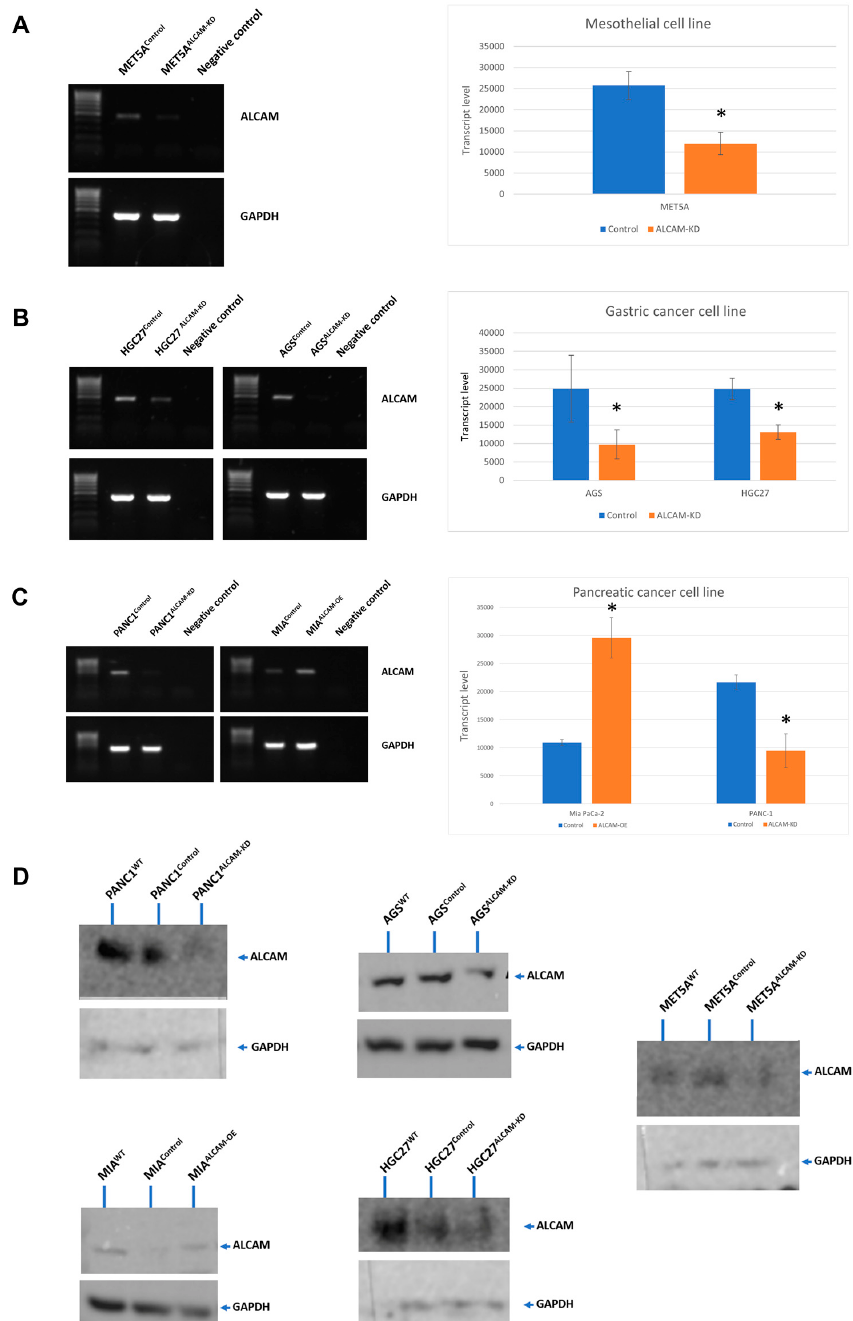
Figure 2. Creation of cell models with differential expression of ALCAM as confirmed by PCR ( left panel ) and quantitative PCR ( right panel ). ( A ): The ALCAM transcript expression in MET5A control (MET5A Control ) and ALCAM knockdown cells (MET5A ALCAM-KD ). ( B ): The AL- CAM transcript expression levels in HGC-27 control (HGC27 Control ) and ALCAM knockdown cells (HGC27 ALCAM-KD ) ( left ), as well as AGS control (AGS Control ) and ALCAM knockdown cells (AGS ALCAM-KD ) ( right ). ( C ): The ALCAM transcript expression levels in PANC-1 Control (PANC1 Control ) and ALCAM knockdown cells (PANC1 ALCAM-KD ) ( left ), as well as MIA PaCa-2 Control (MIA Control ) and ALCAM overexpression cells (MIA ALCAM-OE ) ( right ). *: ALCAM-modified cell lines which showed significant changes compared with their respective control cells ( p < 0.05). ( D ): Knockdown of ALCAM protein in the respective cell lines as shown by protein